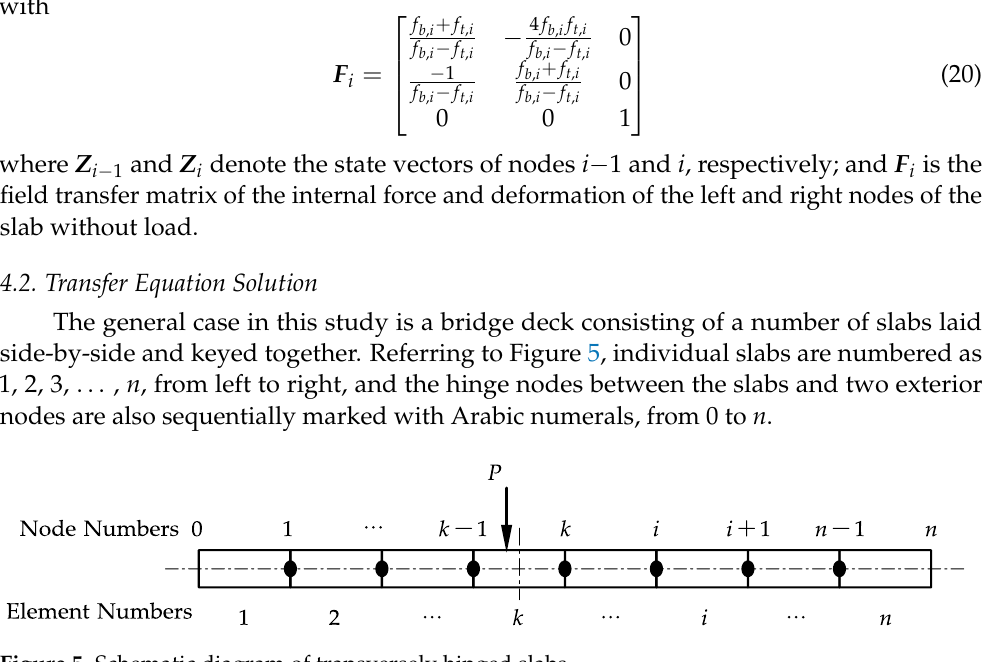
Figure 5. Schematic diagram of transversely hinged slabs.